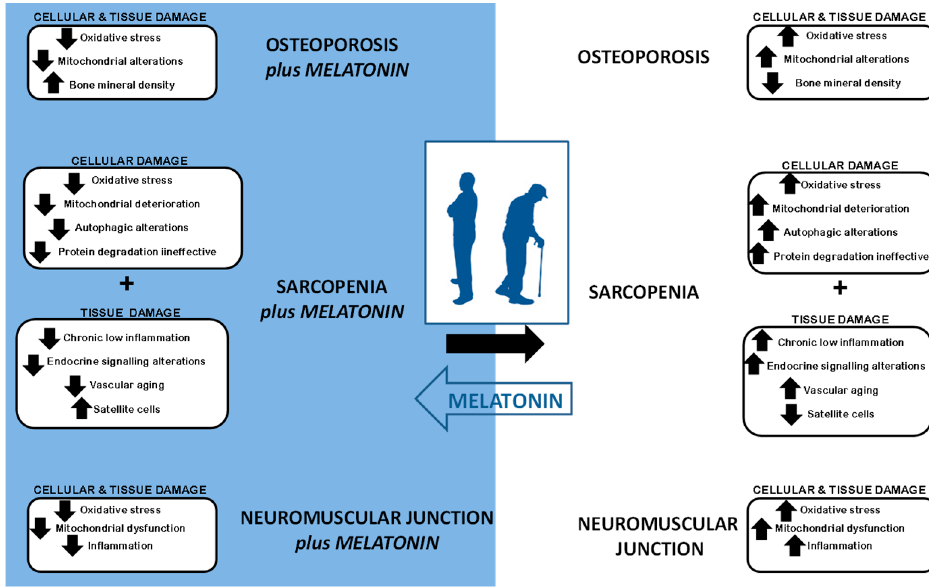
Figure 1. Schematic overview of the potential beneficial effects of melatonin in osteoporosis, sarcopenia and disruption of the neuromuscular junction.